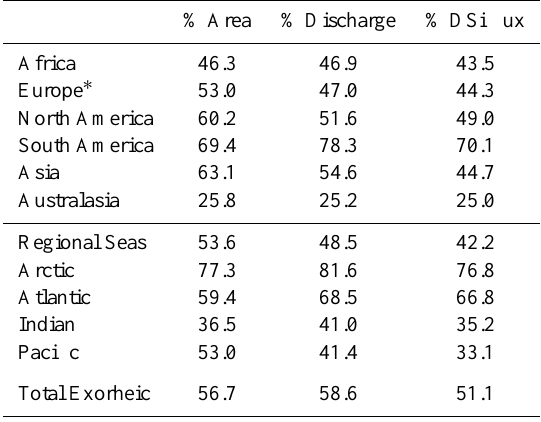
Table 4. Percentages of documented area, discharge and corre- sponding dissolved SiO 2 fluxes for continents, regional seas and ocean drainage basins. % Area %